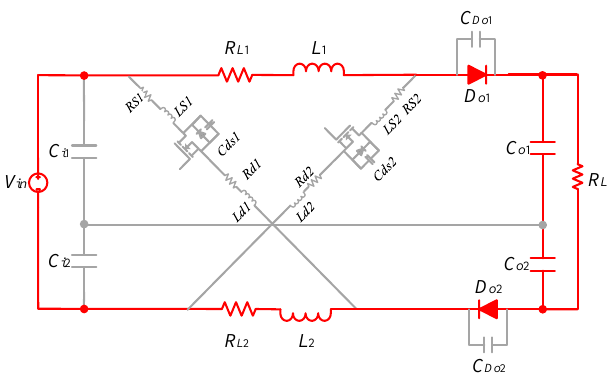
Figure 5. Equivalent circuit of Mode 2.